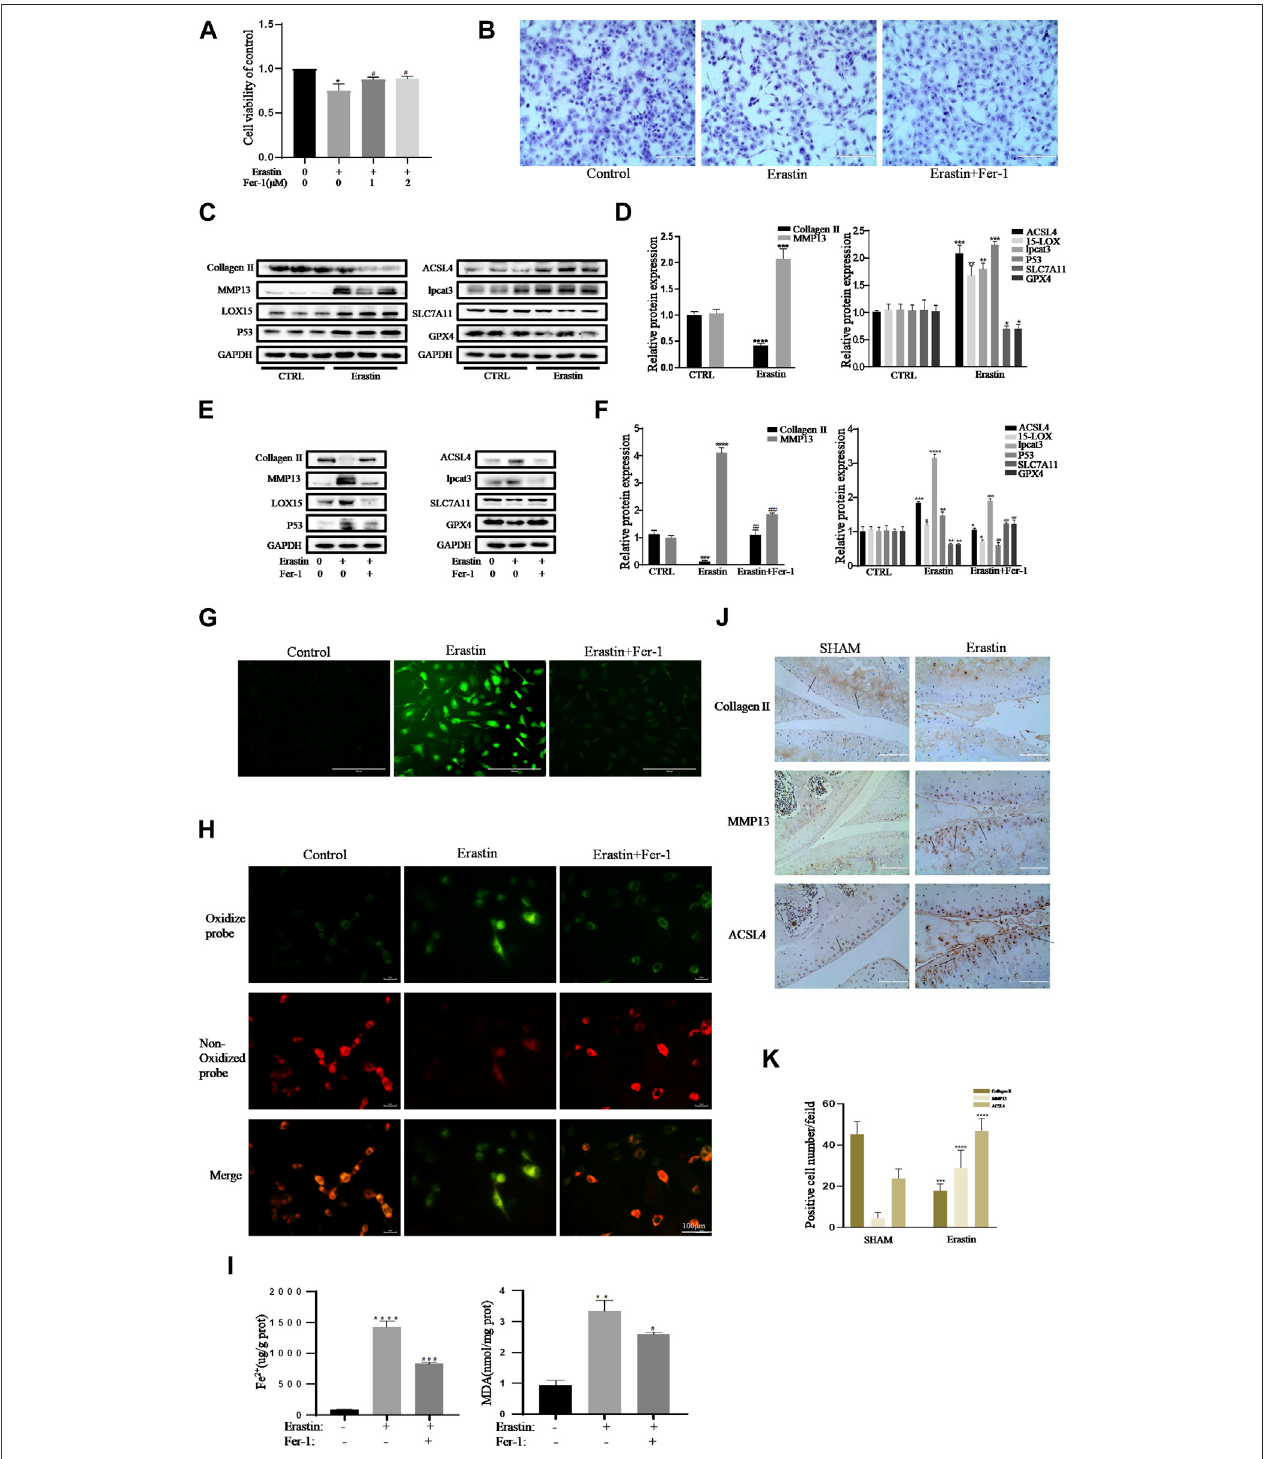
FIGURE3| Erastininitiated in fl ammation responsesand ECMdegradation inchondrocytes thatcould bealleviatedbyFerrostatin-1. (A,B) Cellviabilitydetermined by CCK-8 assay and toluidine blue staining. (C,D) The protein expression levels of collagen Ⅱ , MMP13, ACSL4, LOX15, lpcat3, P53, and SLC7A11 GPX4 when treated by erastin (5 μ M) were detected by Western blot, and band density ratios of collagen Ⅱ , MMP13, ACSL4, LOX15, lpcat3, P53, and SLC7A11 GPX4 to GAPDH in the Western blots were quanti fi ed by densitometry ( n = 3). (E,F) The protein expression levels of collagen Ⅱ , MMP13, ACSL4, LOX15, lpcat3, P53, and SLC7A11 GPX4 when treated by Erastin (5 μ M) with fer-1 (1 μ M) or equal volume of DMSO were detected by Western blot, and band density ratios of collagen Ⅱ ,